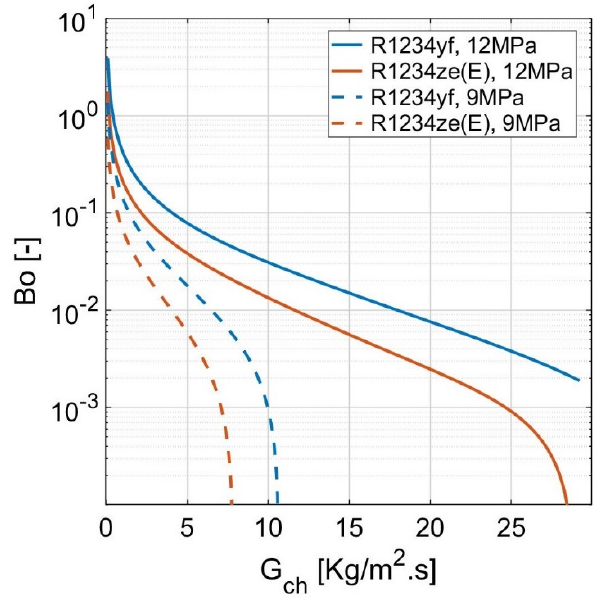
Figure 7. The boiling number at various cold channel mass fluxes.